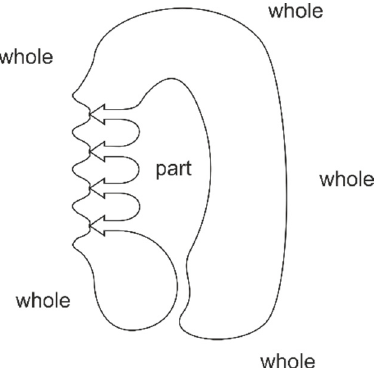
Figure 3. The real situation of the existence of the discursive space.